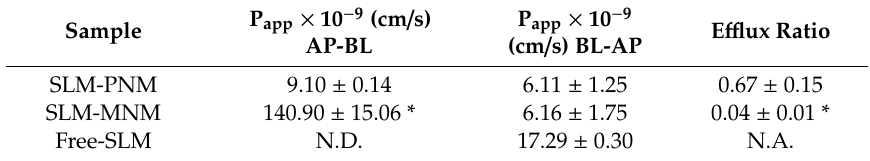
Table 7. Apparent permeability coe ffi cients (P app ) of free-SLM and SLM-loaded nanomicelles. (Mean ± SD, n = 3).